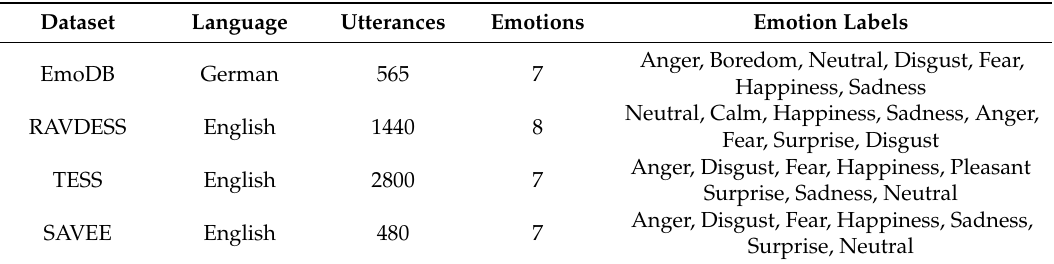
Table 1. Overview of the selected